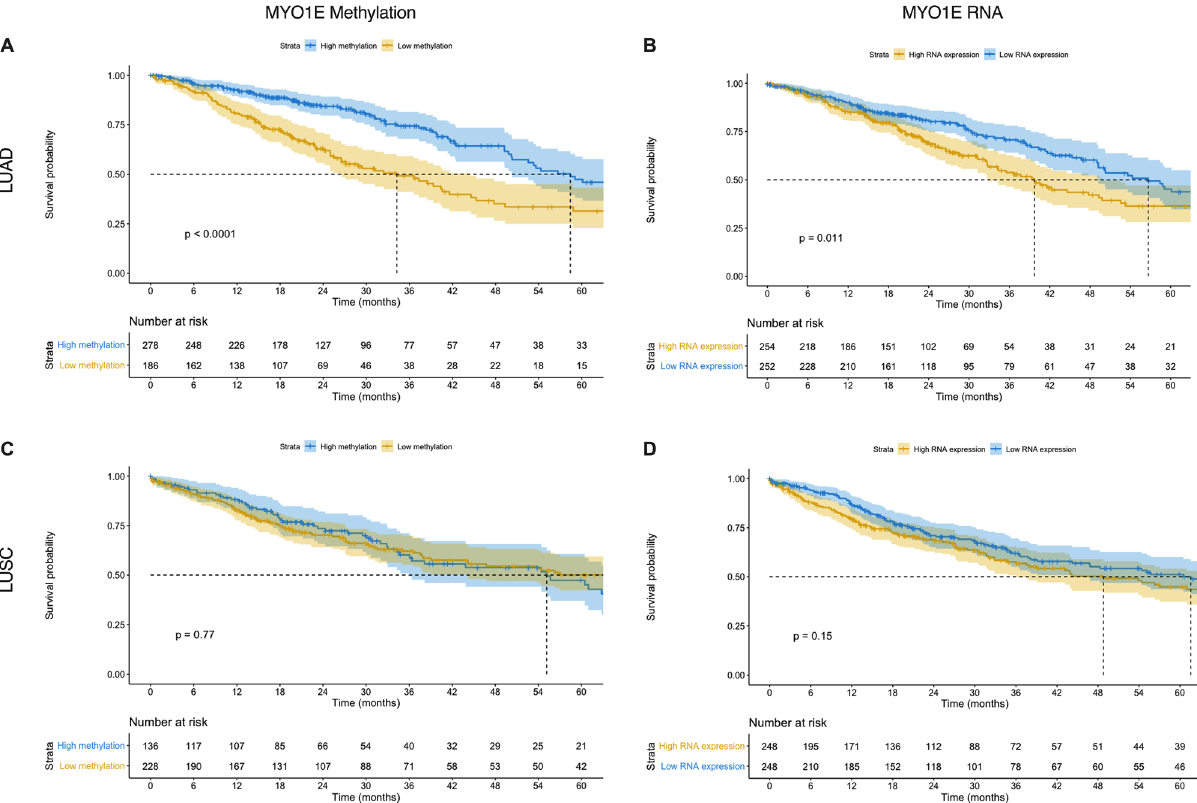
Figure 4. Patients with low DNA methylation and high RNA expression of MYO1E have significantly shorter median survival time in LUAD, but not in LUSC. Kaplan Meier survival curves with log-rank p values and numbers at risk when comparing high vs low MYO1E DNA methylation on the left and high vs low MYO1E RNA expression on the right for LUAD (top row) and LUSC (bottom row). ( A ) High vs low MYO1E DNA methylation for LUAD. ( B ) High vs low MYO1E RNA expression for LUAD. ( C ) High vs low MYO1E DNA methylation for LUSC. ( D ) High vs low MYO1E RNA expression for